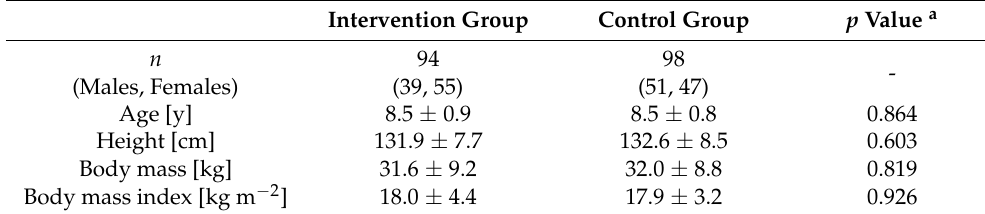
Table 1. Descriptive characteristics of participants in the intervention and control groups. Data are mean ± SD. Intervention Group Control Group p Value a n 94 98 - (Males, Females) (39, 55) (51, 47) Age [y] 8.5 ± 0.9 8.5 ± 0.8 0.864 Height [cm] 131.9 ± 7.7 132.6 ± 8.5 0.603 Body mass [kg] 31.6 ± 9.2 32.0 ± 8.8 0.819 Body mass index [kg m − 2 ] 18.0 ± 4.4 17.9 ± 3.2